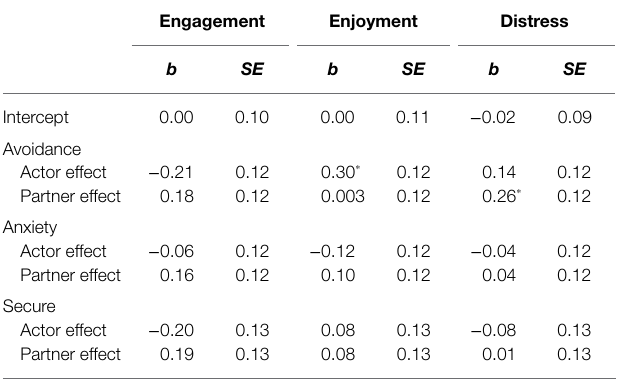
TABLE 5 | The actor and partner effects of attachment orientation on exploratory behavior.